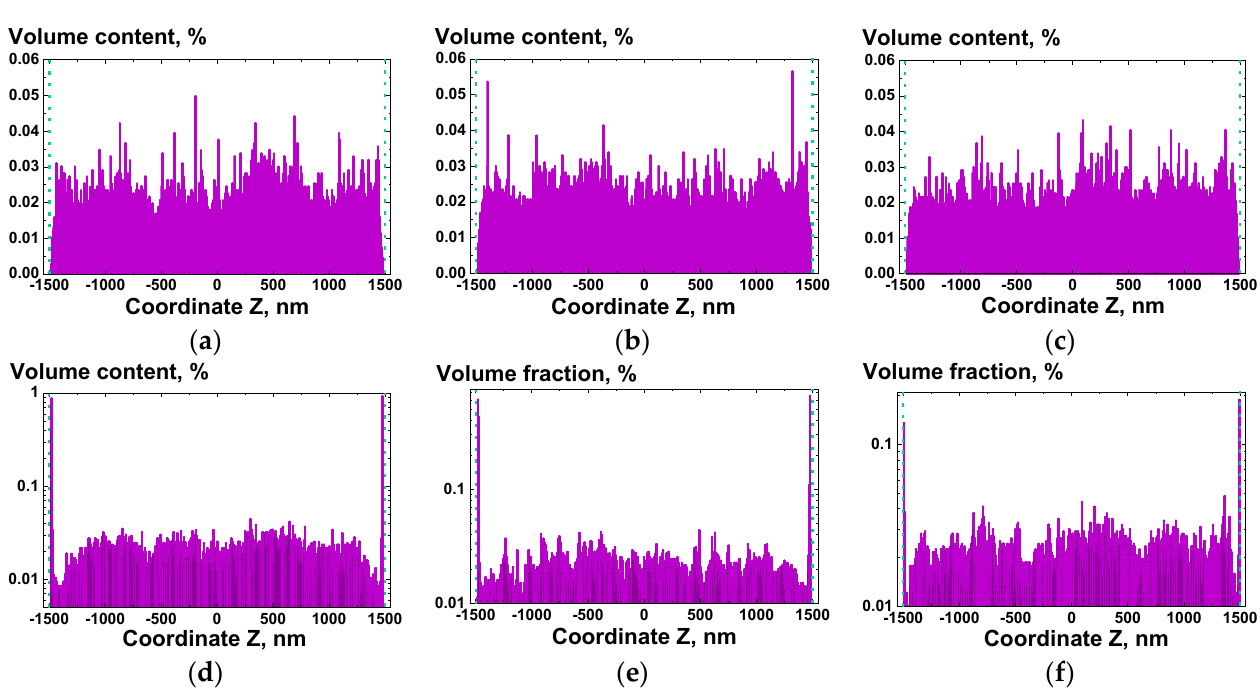
Figure 16. Results of numerical simulation using MD methods for composites containing CNTs with a total volume fraction of 0.5 vol%, for the distribution of the filler along the Z axis at a time step 0 ( a – c ) and at a time step 1000 ( d – f ) for different amplitudes of interaction forces: ( a , d )—weak CNT/CNT, strong CNT/wall; ( b , e )—strong CNT/CNT, strong CNT/wall; ( c , f )—weak CNT/CNT, weak CNT/wall interactions.